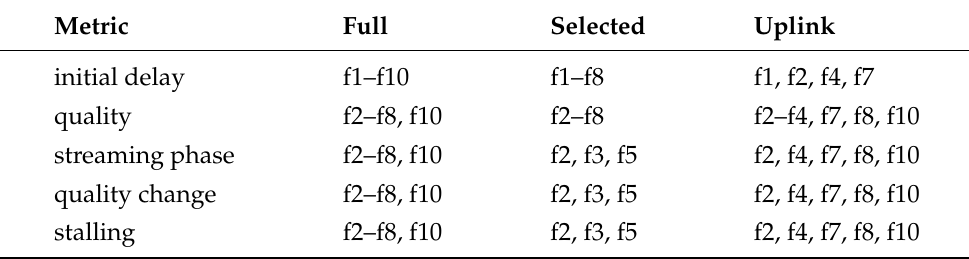
Table 7. Overview of all feature